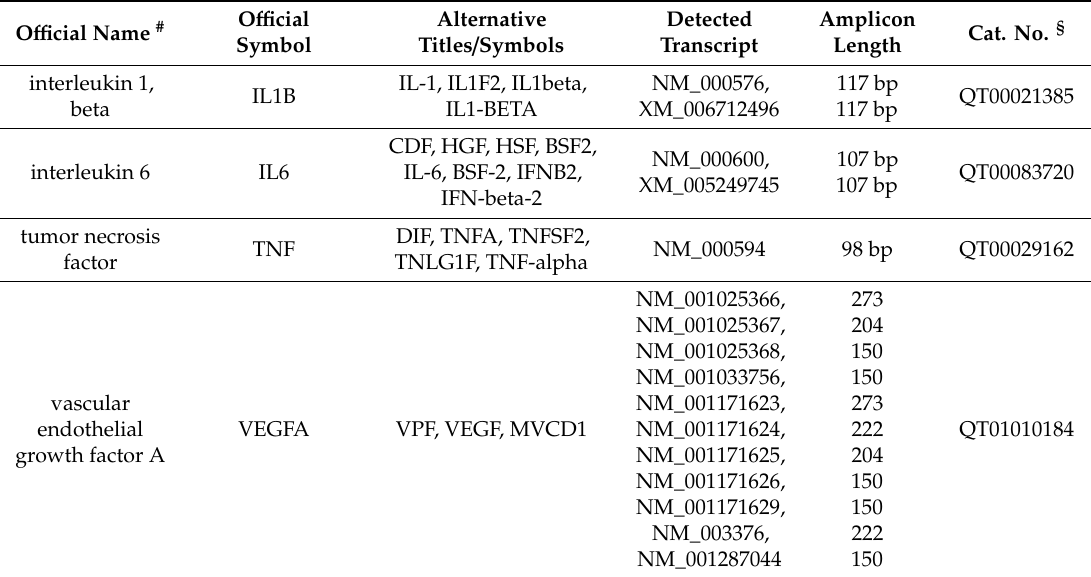
Table 2. The list of primers used for